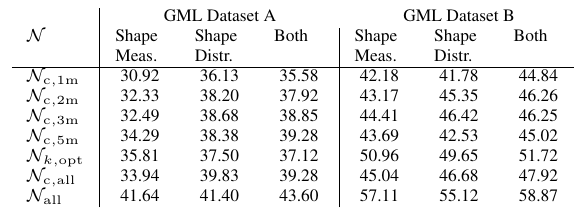
Table 4. MCR (in %) for different neighbourhood definitions and different feature sets.